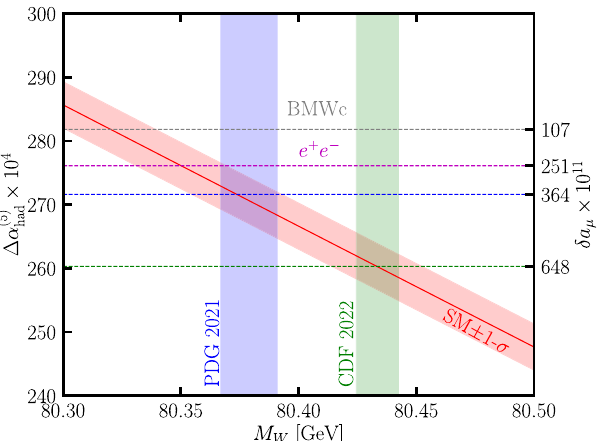
Fig. 2 | Correlation of Δ α had with M W in the electroweak fi ts. The allowed values of Δ α had assumingspeci fi cvaluesofthe W bosonmassintheSMfoundfromEW fi ts. The solid line indicates the central value from the fi t without any input for Δ α had , while the red band shows the 1 σ region. The currentworld average (PDG 2021)and new measurement (CDF 2022) for M W are indicated by vertical bands. We indicate the favoured Δ α had from BMW lattice calculations (grey), e + e − cross section mea- surements (magenta), our fi t using M W from PDG 2021 (blue) and our fi t using M W from CDF 2022